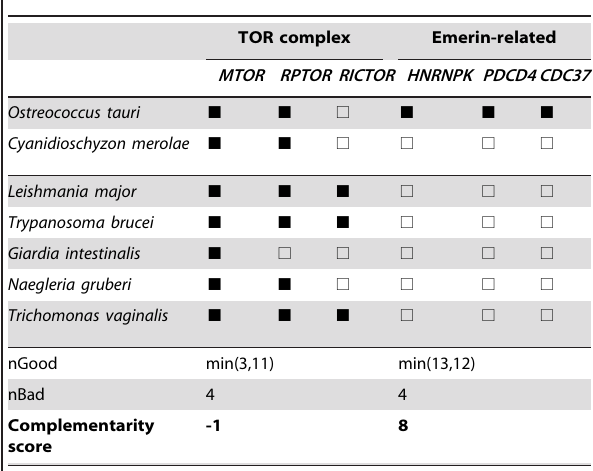
Left: a protein triplet from the TOR complex, right: a triplet from emerin-related complexes. The computation of the complementarity score is explained in Figure 1 B.